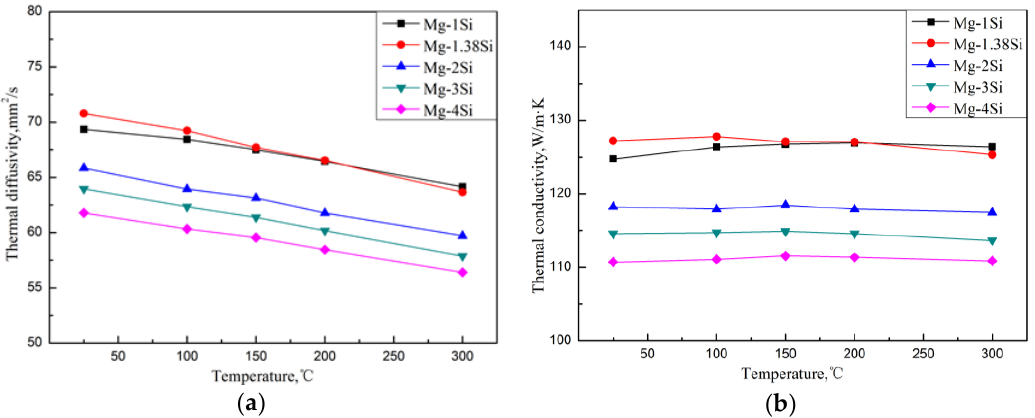
Figure 4. Thermal diffusivity ( a ) and thermal conductivity ( b ) of Mg – Si binary alloys.